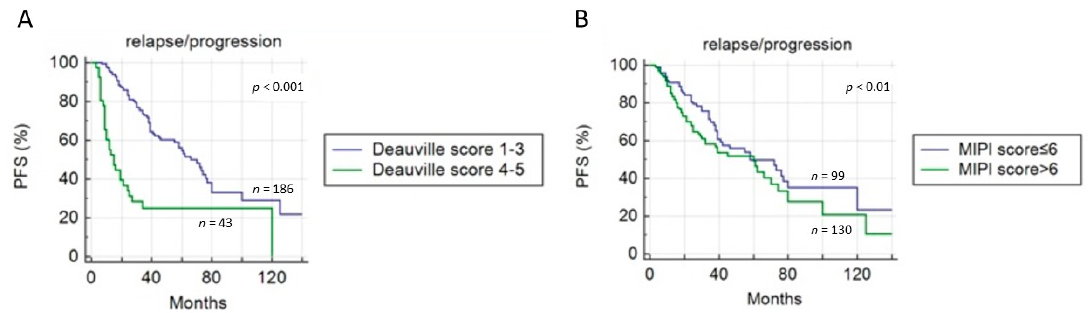
Figure 3. Progression-free survival (PFS) curves according to end-of-treatment PET/CT results using ( A ) Deauville criteria and ( B ) MIPI score.